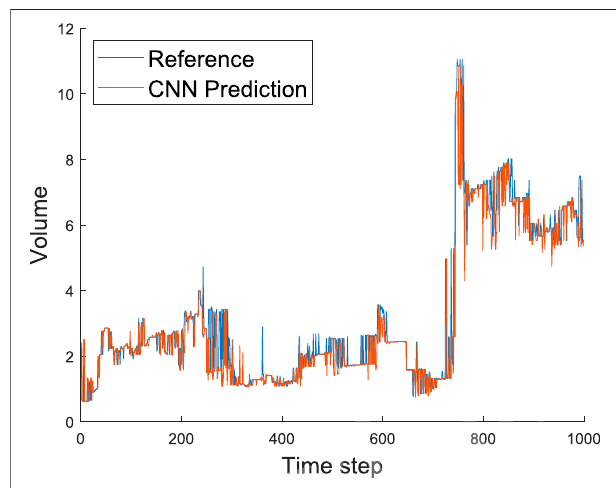
FIGURE 11 | Predicted and reference volume (scaled with h 3 ) of the largest structure in the domain as a function of the time step. Note that the sharp increase at around time step 750 matches the behavior in the wake region documented in Figure 10